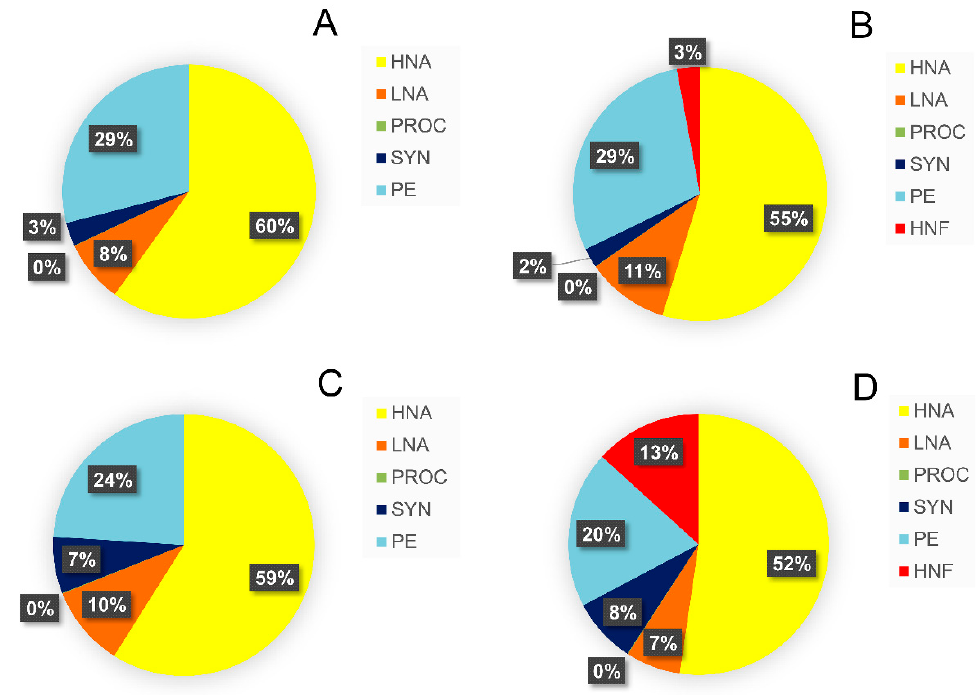
Figure 3. Relative contribution of prey biomass to total biomass ingested by HNF ( A , C ) and ciliates ( B , D ) at ambient temperature of 14 ◦ C ( A , B ) and after a 3 ◦ C rise above ambient temperature ( C , D ). HNA, high nucleic-acid bacteria; LNA, low nucleic-acid bacteria; PROC, Prochlorococcus ; SYN, Synechococcus ; PE, picoeukaryotes; HNF, heterotrophic nanoflagellates.